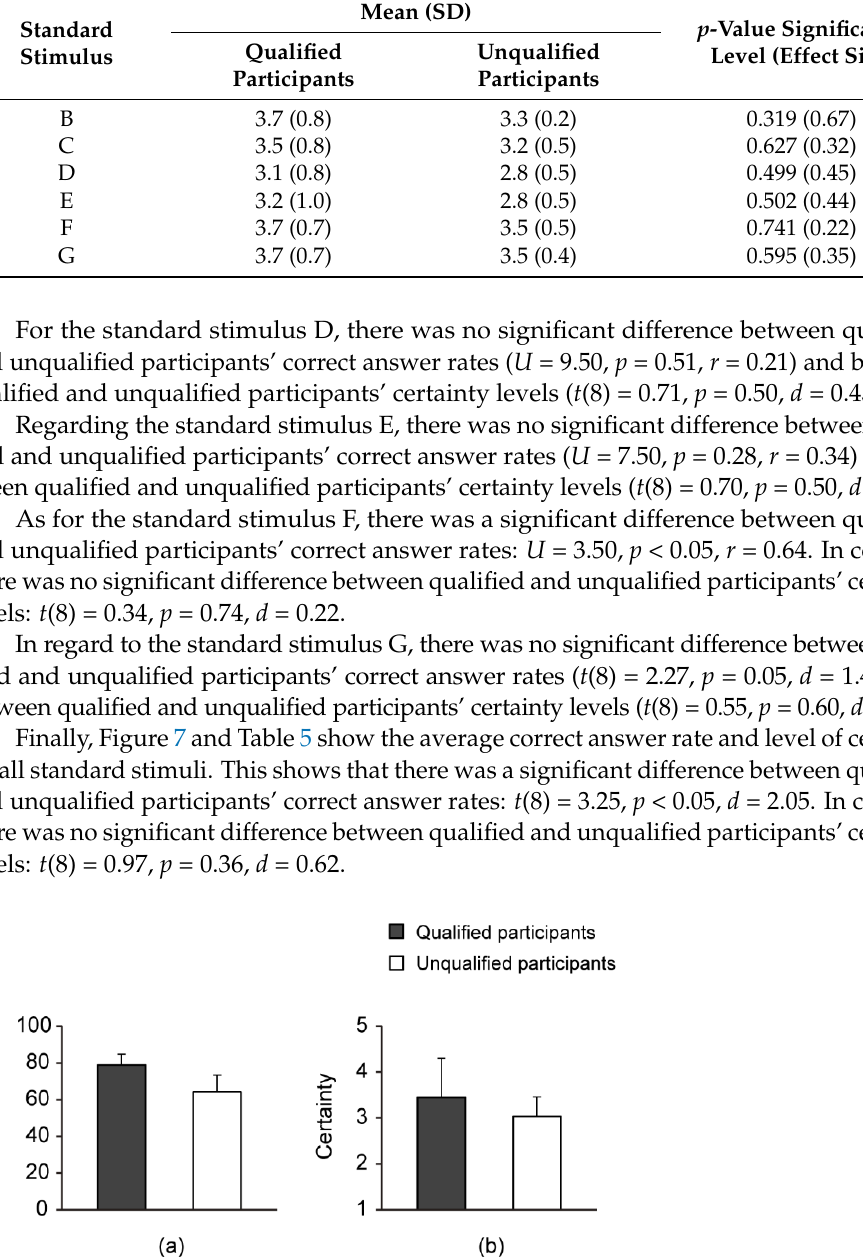
Table 4. T-test with a significance level of 5% to confirm the differences between teachers’ and beginning learners’ certainty level.